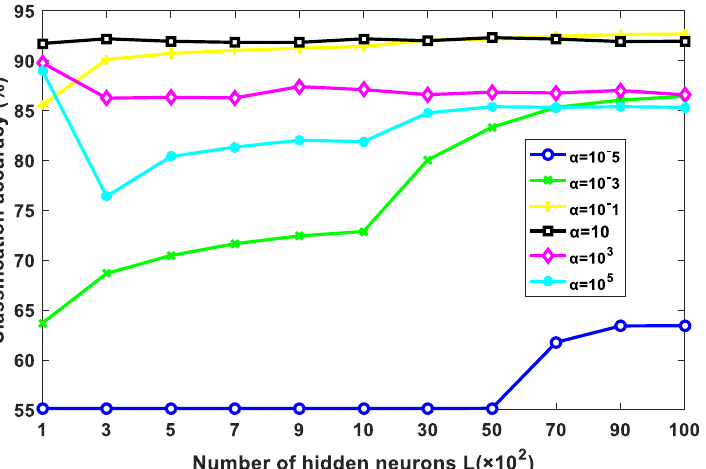
Figure 14. Classification performance variations of NDCA plus ELM under different settings of L